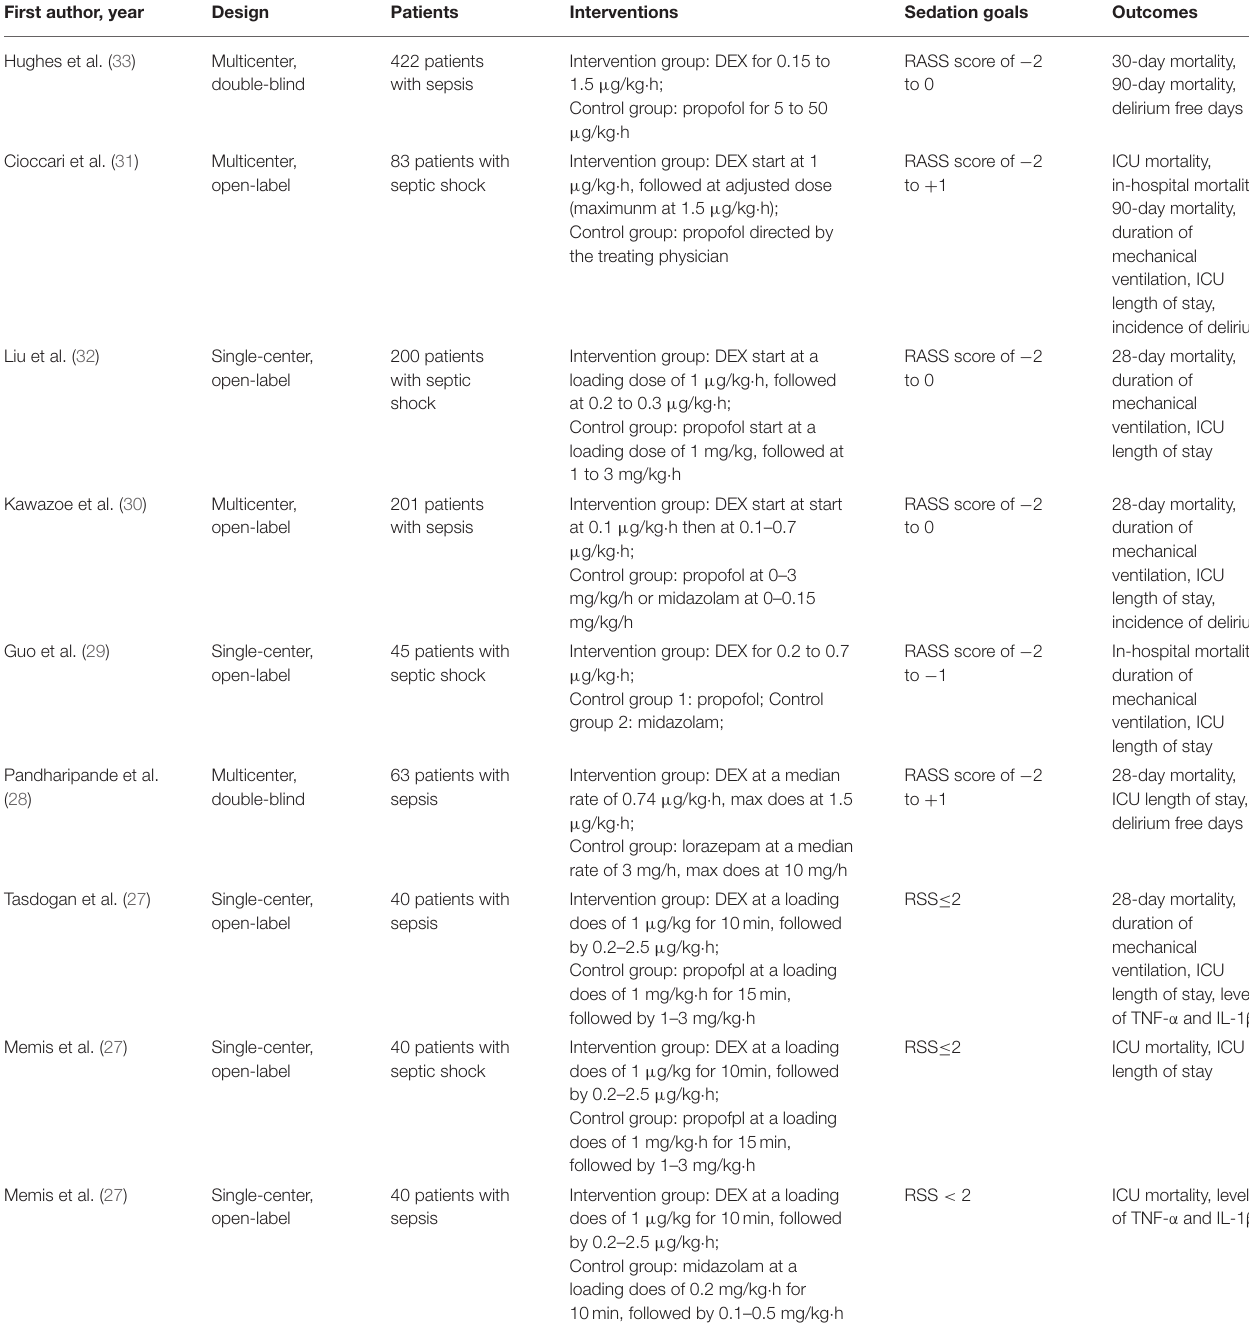
TABLE 1 | Characteristics of the included